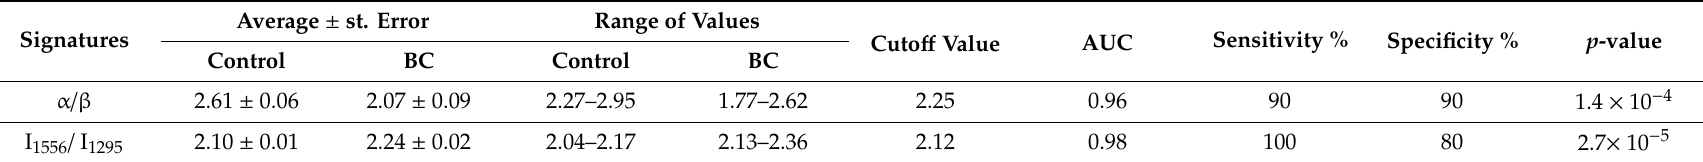
Table 2. Identifying BC-associated discriminatory protein bands in serum samples. These include the integral ratio of Gaussian Function Energy Bands (GFEB), representing α -helix and β -sheet protein secondary structures, as well as the absorbance ratio of amide II (1556 cm − 1 ) to amide III (1295 cm − 1 ). Quantified values (in A.U.) of the average and range of spectral signatures taken from the control and BC samples. The optimal cuto ff and the corresponding sensitivity, specificity, and p -values are also